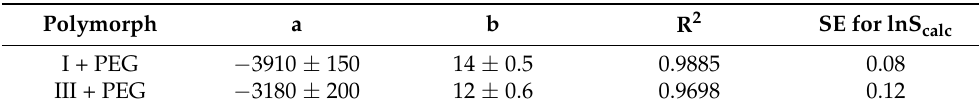
Table 2. Coefficients of the van’t Hoff equation for solubility curves of 2,6MeOBA polymorphs in 1% aqueous solution of